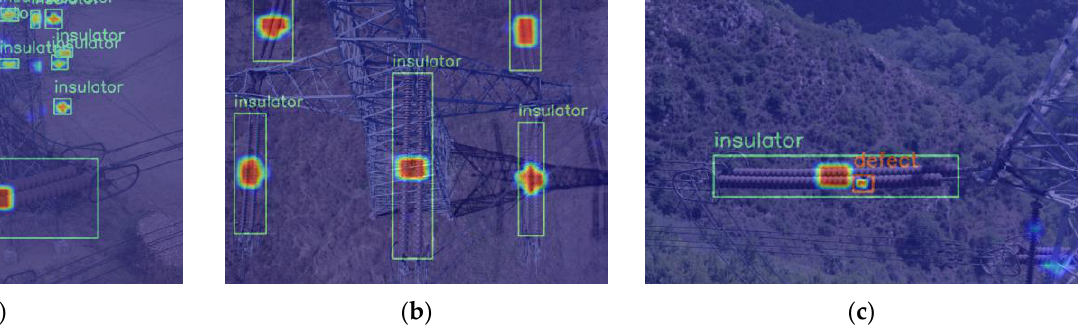
Figure 11. Heat map of the detection with the ECA embedded: ( a ) nine insulators have been de- tected; ( b ) five insulators have been detected; ( c ) one insulator and one defect have been detected.